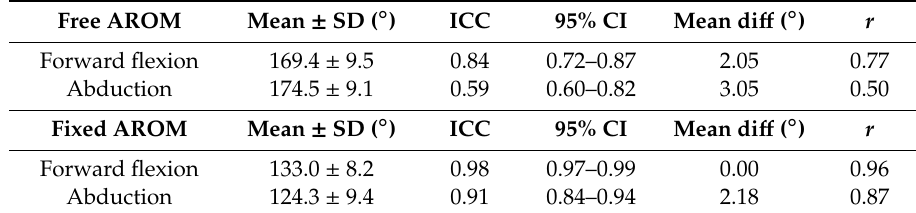
Table 5. Correlation between HumanTrak and goniometry ( n = 50).